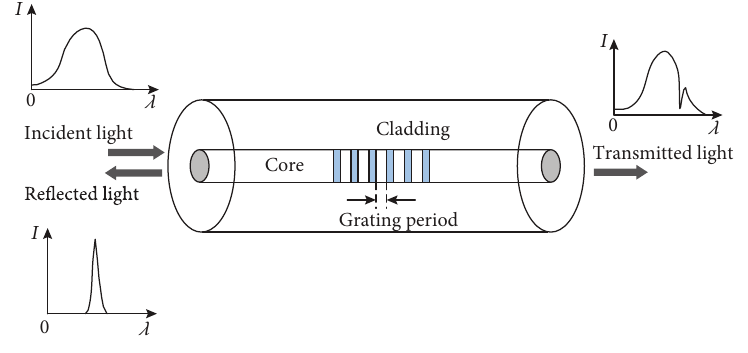
Figure 1: FBG measurement principle